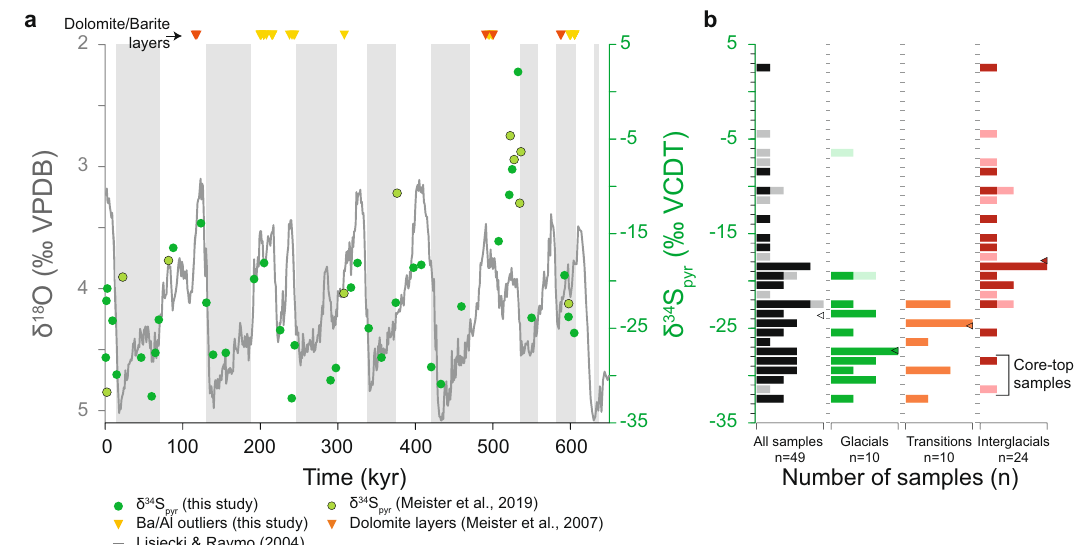
Fig. 2 The temporal record and distributions of δ 34 S pyr at ODP 201 — site 1229. a δ 34 S values preserved in sedimentary pyrite over the last 610 ky, as measured in this study and in ref. 28 . For the global climatic context, deep-sea δ 18 O values from benthic foraminifera 30 are shown in gray. b Histograms of δ 34 S pyr preserved in Peruvian margin sediment under different climatic conditions. Histogram means are shown by triangles. Dark bars refer to this study, whereas light bars correspond to data from ref. 28